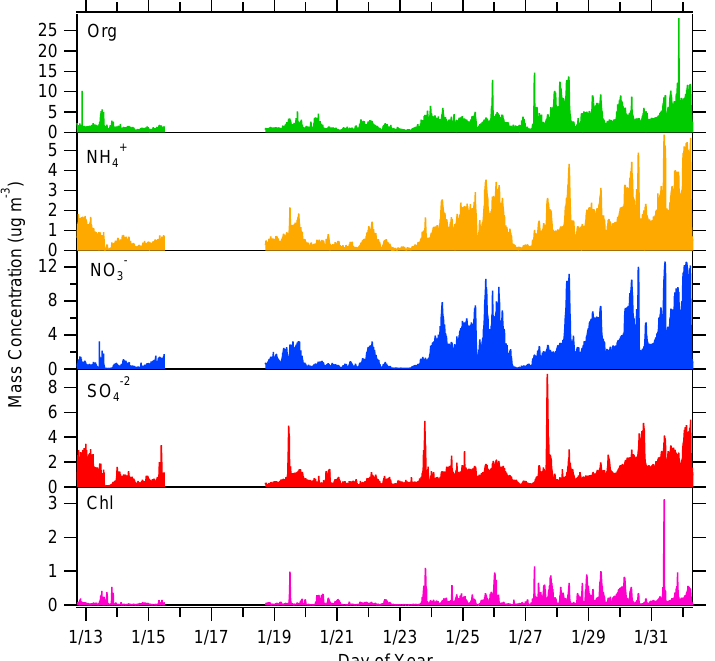
Figure 3. Time series of AMS-measured non-refractory sub-micron PM